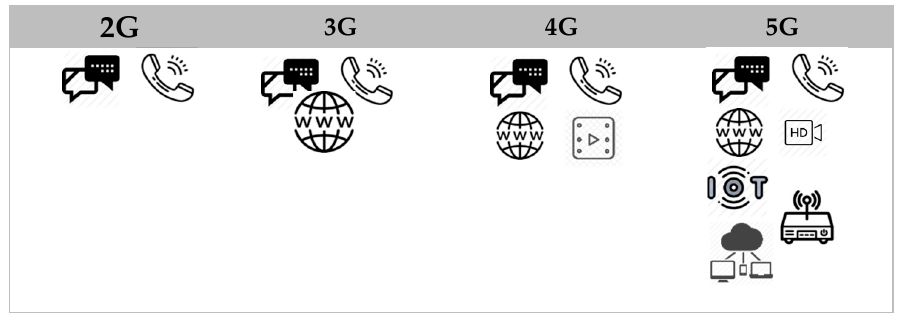
Figure 1. Road to 5G networks and their diverse services .